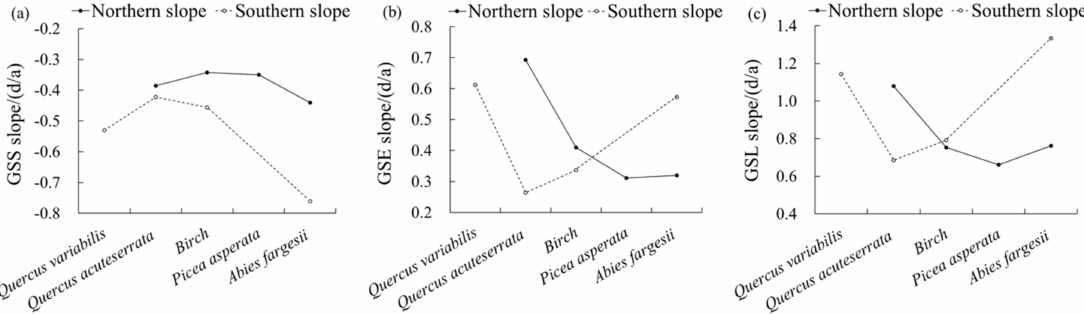
Figure 6. Change trends of vegetation phenological parameters on the different vegetation vertical zones in Niubeiliang Reserve from 2000 to 2017. ( a ) GSS slope of vegetation vertical zones; ( b ) GSE slope of vegetation vertical zones; ( c ) GSL slope of vegetation vertical